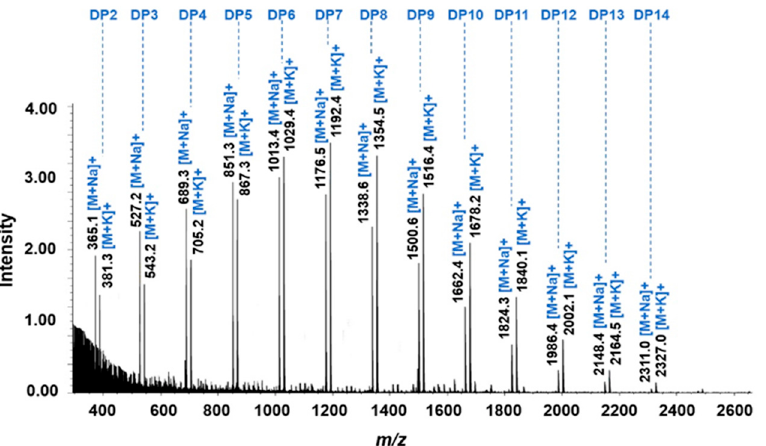
Figure 2. MALDI-TOF-MS spectra of oligosaccharides obtained from the culture supernatant of B. subtilis strain AP-1 at 36 h.